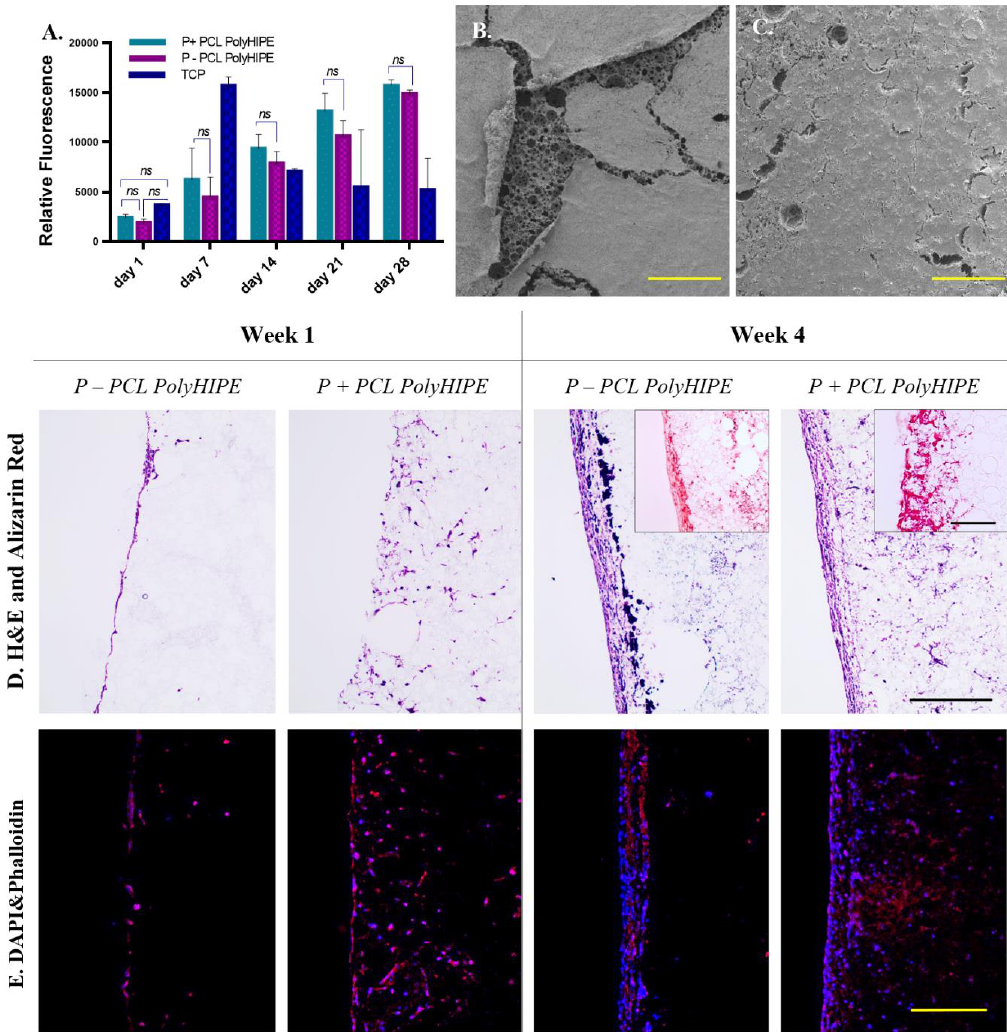
Figure 3. ( A ) Metabolic activity of murine long-bone osteocytes (MLO-A5s) cultured on P-, P+ PCL polyHIPEs, and tissue culture plate (TCP) for 4 weeks. SEM images of the top surfaces of ( B ) P+ and ( C )P-PCLpolyHIPEsculturedMLO-A5sonfor4weeks(Scalebarrepresents500 µ m). ( D )Haematoxylin ( C ) P- PCL polyHIPEs cultured MLO-A5s on for 4 weeks (Scale bar represents 500 µm). ( D ) Haematoxylin and eosin (H&E) and Alizarin red, and ( E ) fluorescent staining of MLO-A5s cultured on P+ and P- PCL polyHIPEs for 1 week and 4 weeks (Scale bar represents 250 µm, blue: (DAPI), red: phalloidin tetramethylrhodamine 4',6-diamidino-2-phenylindole (DAPI), red: phalloidin tetramethylrhodamine (TRITC)).